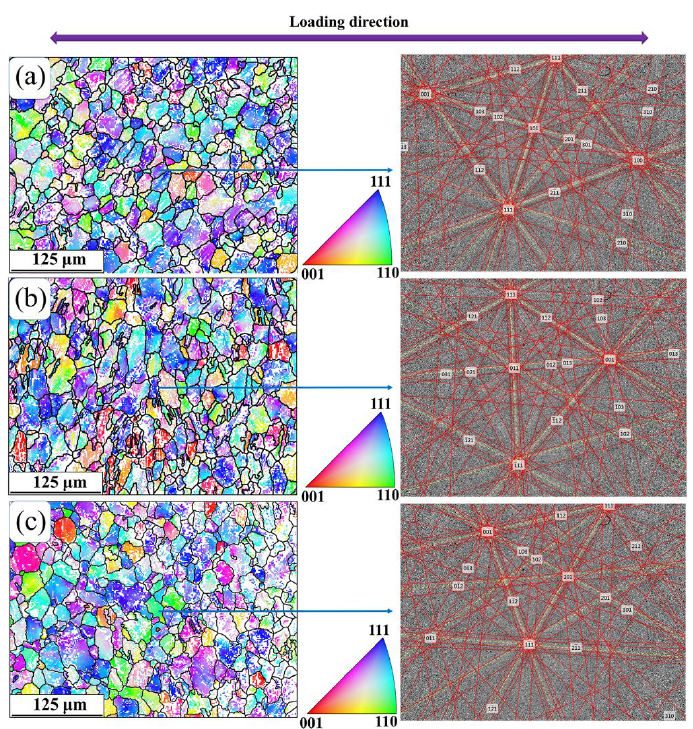
Figure 3. Microstructure evolution and corresponding Kikuchi patterns of NiTi SMA subjected to various deformation degrees: ( a ) 20%; ( b ) 30%; ( c ) 40%.